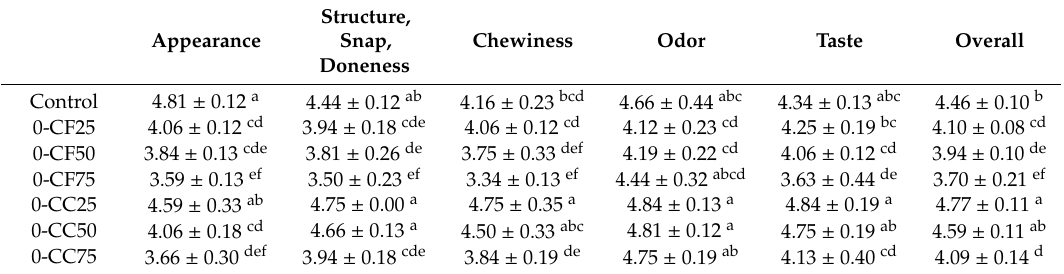
Table 2. Sensory evaluation of cookies with 25%, 50% and 75% of fine and coarse APF after production. Structure, Appearance Snap, Doneness